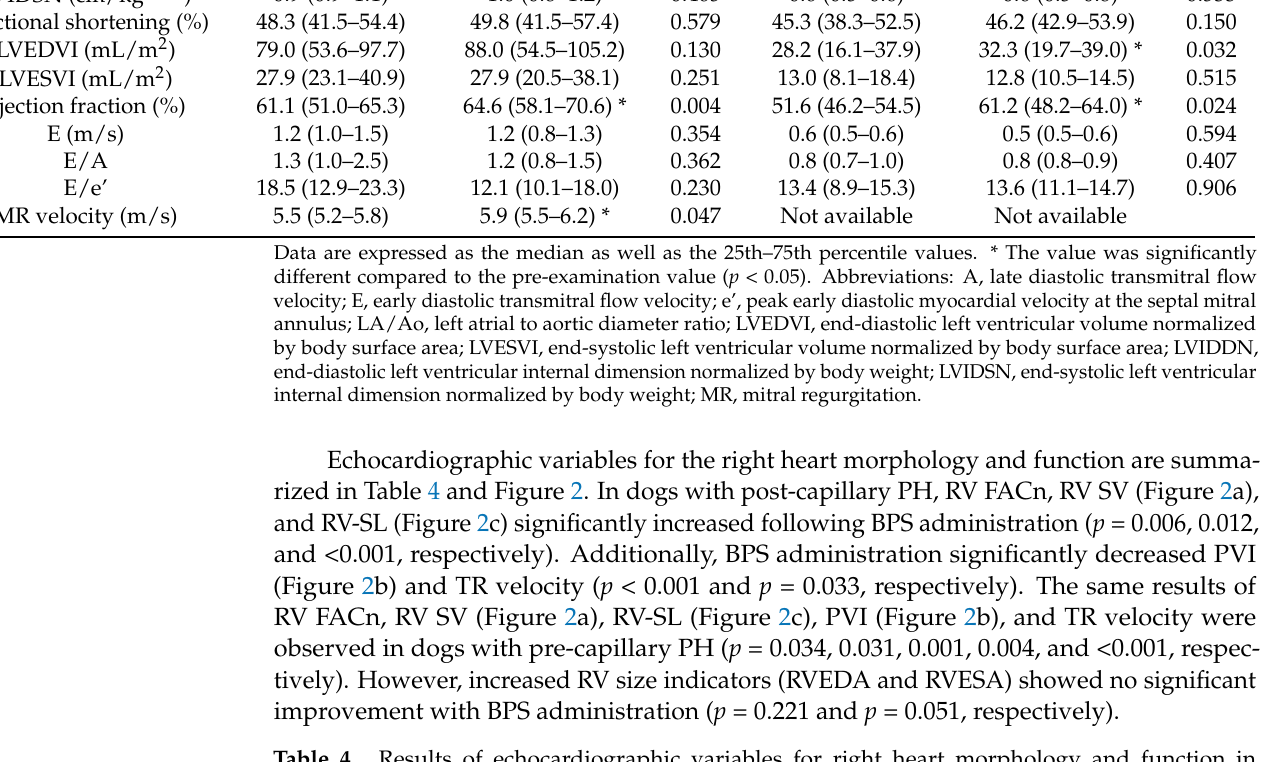
Table 4. Results of echocardiographic variables for right heart morphology and function in dogs with post-capillary and pre-capillary pulmonary hypertension before and after beraprost sodium